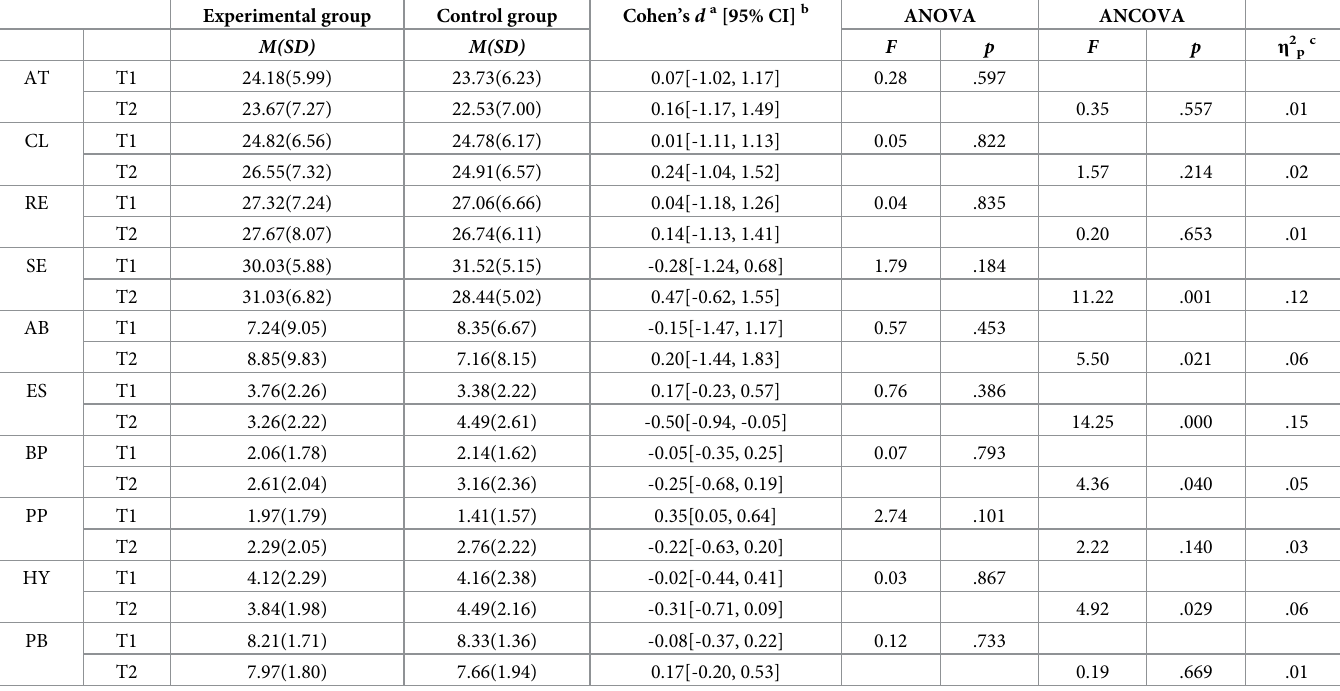
Table 3. Impact of the programme comparing the experimental group and the control group. Experimental